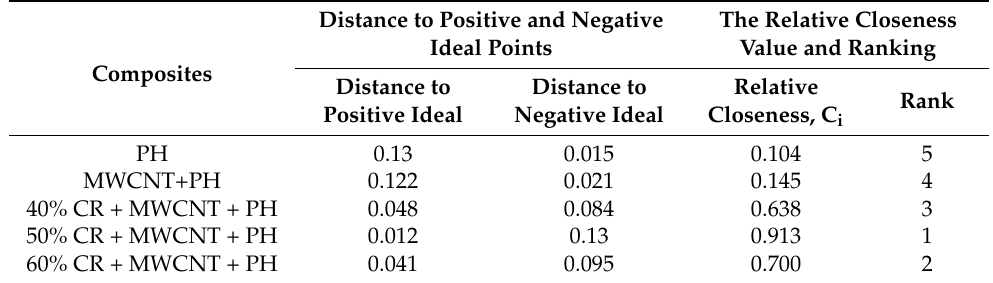
Table 10. Distance to positive, negative ideal points and the relative closeness value and